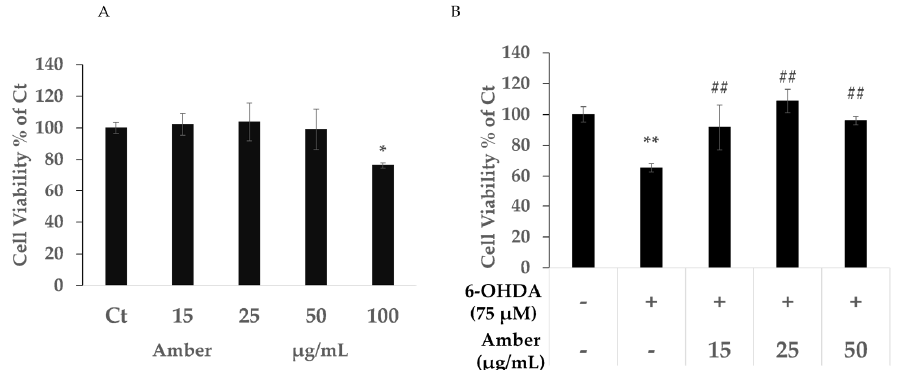
Figure 1. Effect of amber extract on 6-hydroxydopamine (6-OHDA)-induced cytotoxicity: SH-SY5Y cells were cultured in DMEM/F12 medium with 10% FBS. After 24 h of seeding, the cells were pretreated with amber extract for 24 h, and then the medium was replaced with fresh 6OHDA-containing medium for another 24 h, after which cell viability was measured using the MTT assay. Control (Ct): (6-OHDA/amber) −/−, 6-OHDA: (6-OHDA/amber) +/−, Amber: (6-OHDA/amber) (+/15 μg/mL; +/25 μg/mL, +/50 μg/mL). ( A ) Cytotoxicity of amber extract. ( B ) Effect of amber extract on 6-OHDA-induced cell death. Cell viability was determined using the 3-(4,5-dimethylthiazol-2-yl)-2,5-diphenylterazolium bromide assay. The results are expressed as the mean ± standard deviation. n ≥ 3, * p < 0.05 vs. Control, ** p < 0.01 vs. Control, ## p < 0.01 vs. 6-OHDA.